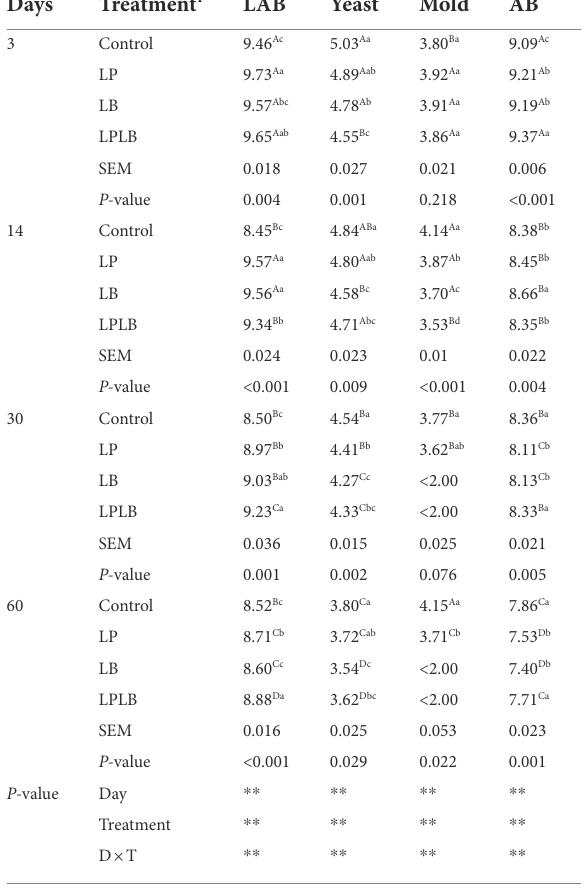
Means of three observations. Different lowercase letters indicate significant differences ( P < 0.05) between different treatments at the same time. Different capital letters indicate significant differences ( P < 0.05) between the different times of the same treatment. LAB, lactic acid bacteria; AB, aerobic bacteria. Percentage of Log 10 CFU/g of fresh matter for LAB, yeast, mold, and AB. 1 Control, ensiling with no inoculant applied; LP, inoculated with L. plantarum MZ008357; LB, inoculated with L. brevis MZ008360; LPLB, inoculated with L. plantarum and L. brevis ; SEM, standard error of means. * p < 0.05; ** P < 0.01.